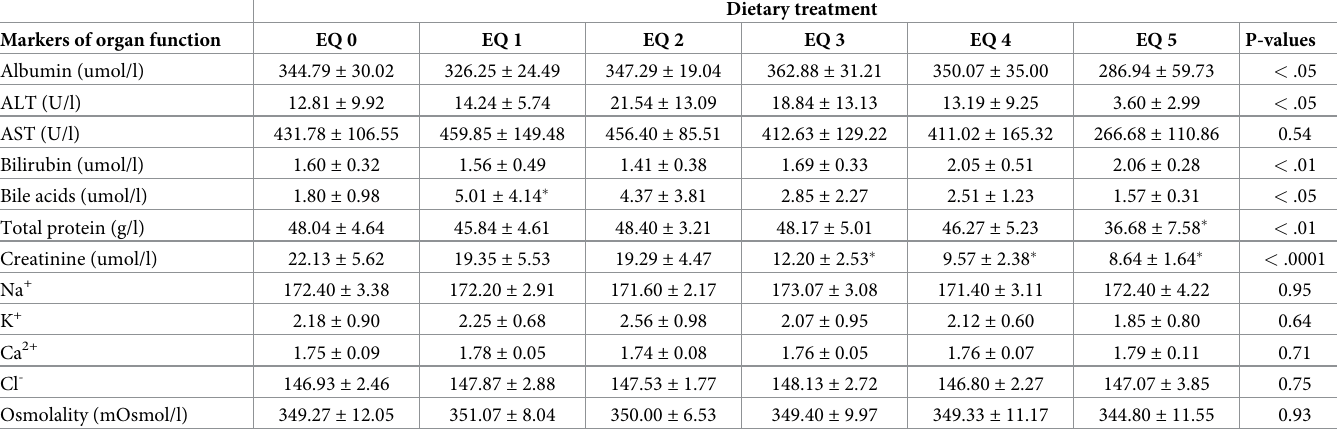
Table 4. Plasma biochemical markers of organ function and stress of Atlantic salmon ( Salmo salar L.) exposed to graded levels of ethoxyquin (EQ) through their diet for 90 days.